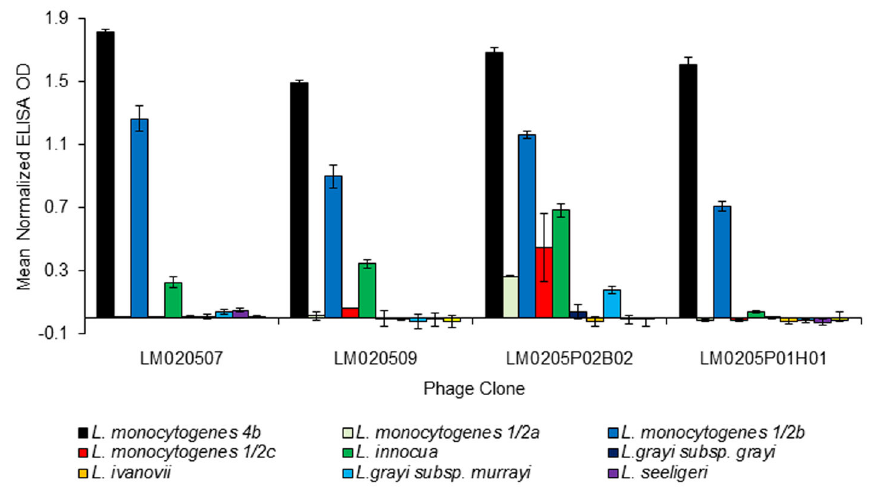
Figure 4. Phage binding ELISA specificity study of the four best L. monocytogenes 4b binding phage clones. Normalized data equates to relative OD signal after subtraction of background OD signal. Experiment performed in duplicate (n=2). Error bars represent ± standard deviation of mean. doi: